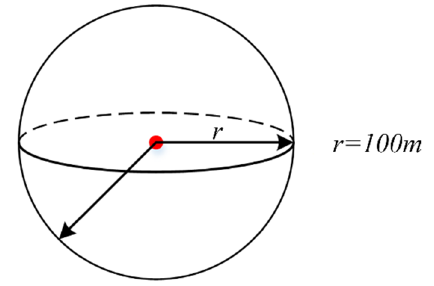
Figure 2. Sonar sensor model.